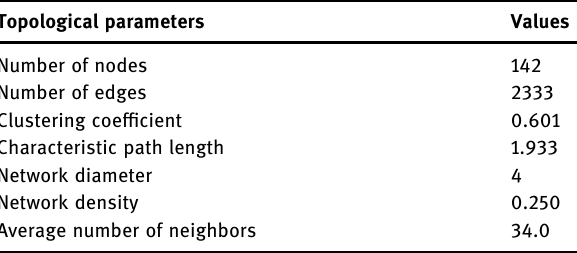
Table 4: Topological parameters of the network Topological parameters Values Number of